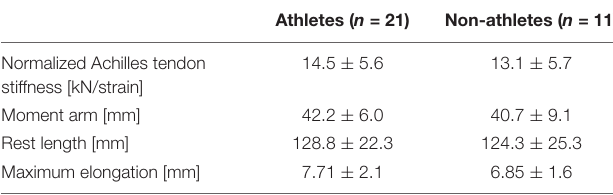
TABLE 5 | Achilles tendon properties of the preadolescent athletes and non-athletes.